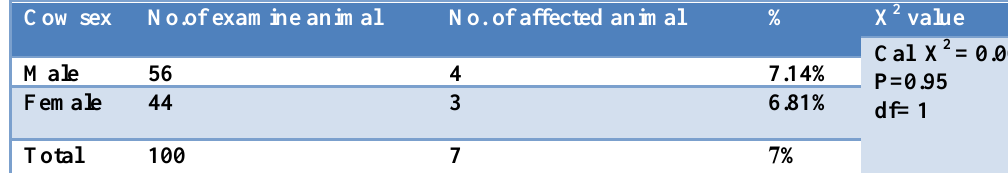
Table, 5: Distribution of Salmonella species according to sex of animal